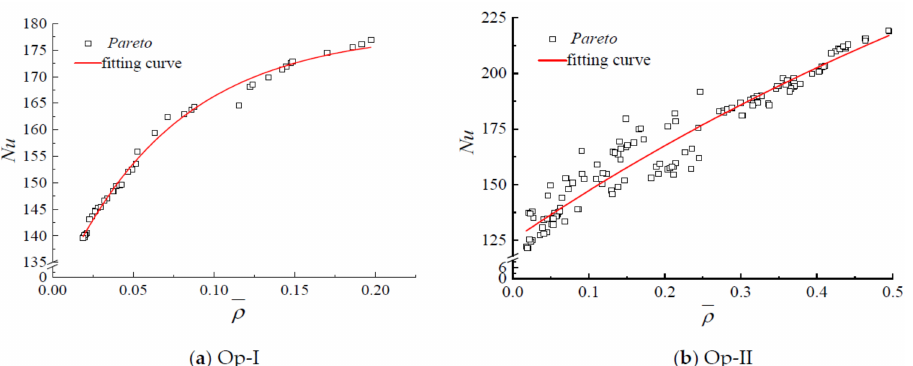
Figure 9. Pareto fronts and fitting